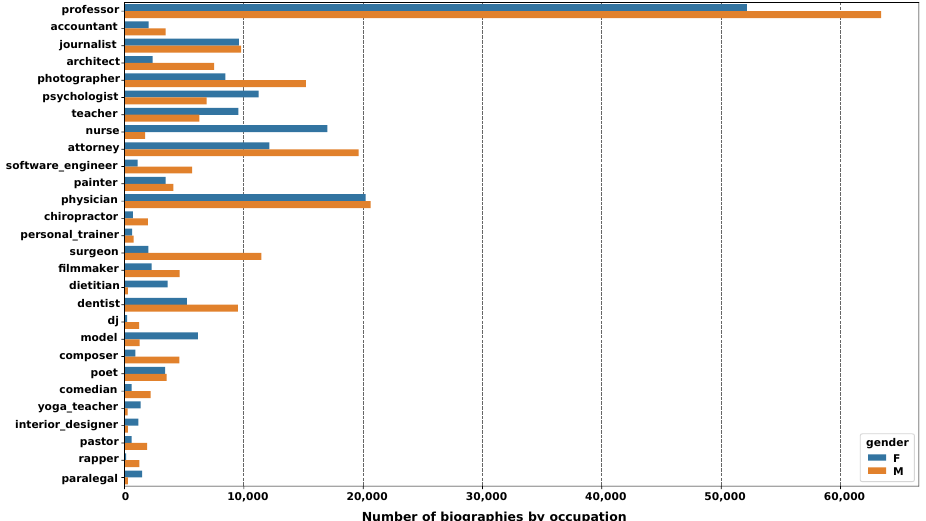
Figure 1. Number of biographies for each occupation by gender on the total Bios dataset